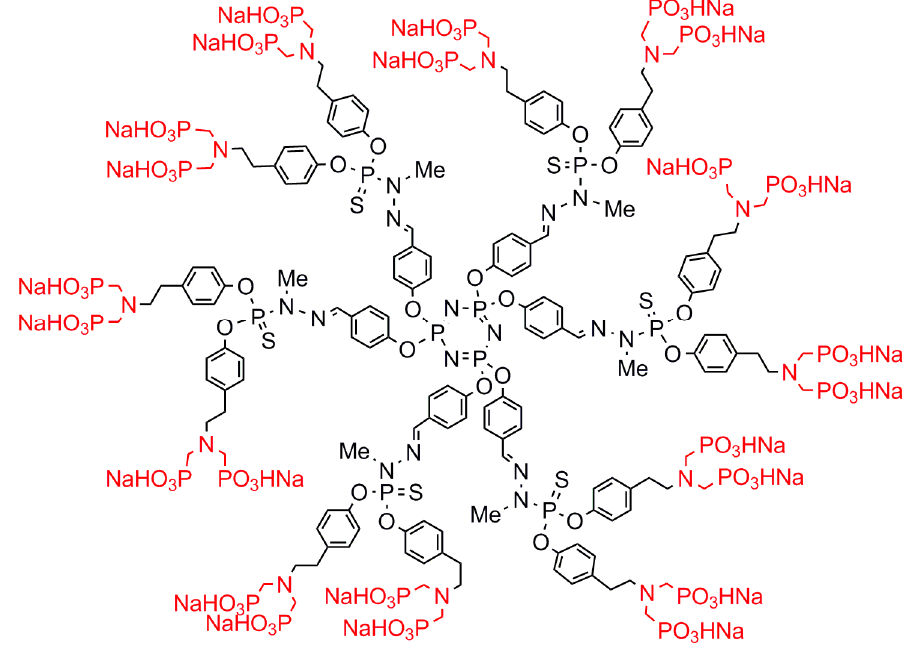
Figure 3. First-generation phosphorhydrazone dendrimer with azabisphosphonate terminal functions First-generation phosphorhydrazone dendrimer with azabisphosphonate terminal (ABP). functions